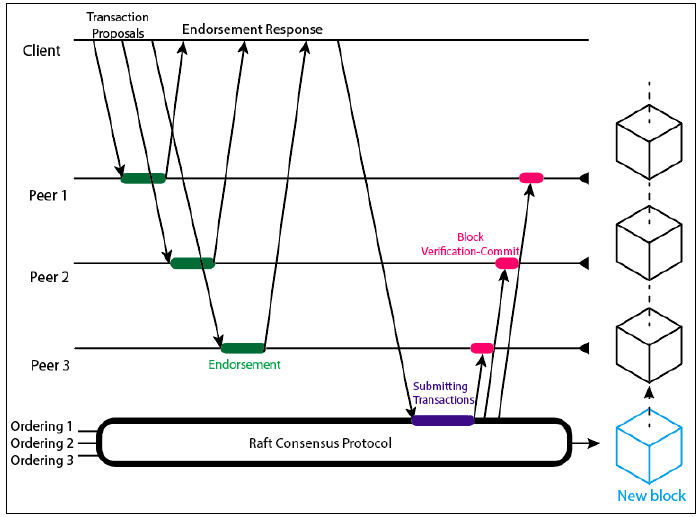
Figure 2. Raft consensus workflow